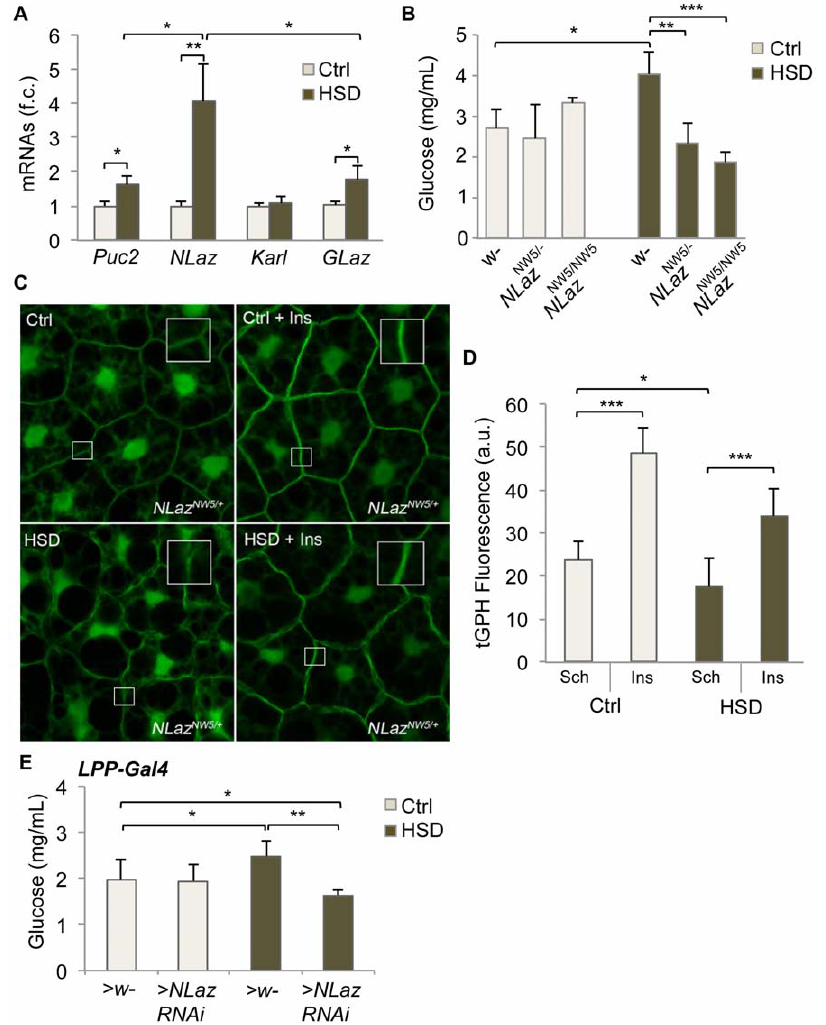
Figure 3. NLaz is required for High Sugar Diet-induced Dilp-resistance. (A) Changes in expression of Puc , NLaz , Karl and GLaz in HSD vs control conditions (fold changes are presented, f.c.). (B) Glycemia of control, heterozygous and homozygous NLaz mutant larvae fed either normal diet (light grey bars) or HSD (dark bars). (C) and (D) Fat body explants from NLaz mutant larvae fed either control or HSD were exposed to human insulin (0,5 m M, 20 min.). The amount of tGPH fluorescence was quantified as an evaluation of insulin sensitivity. (E) Glycemia of control larvae or larvae with a fat body-specific knock-down of NLaz ( NLaz-RNAi ), fed either normal diet (light grey bars) or HSD (dark bars).